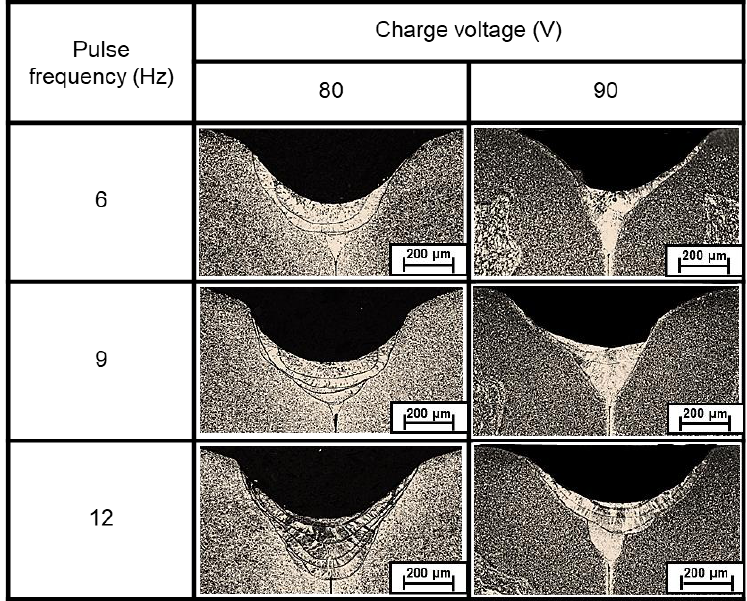
Figure 11. Cross-sectional macro structure.